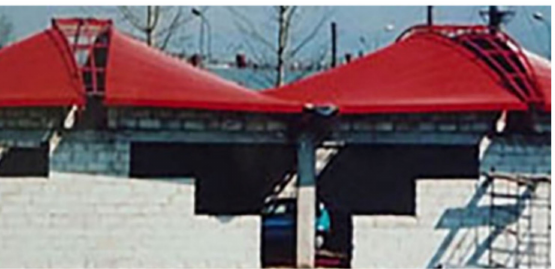
Figure 1. Transformed roof shells characterized by the top layer composed of visible